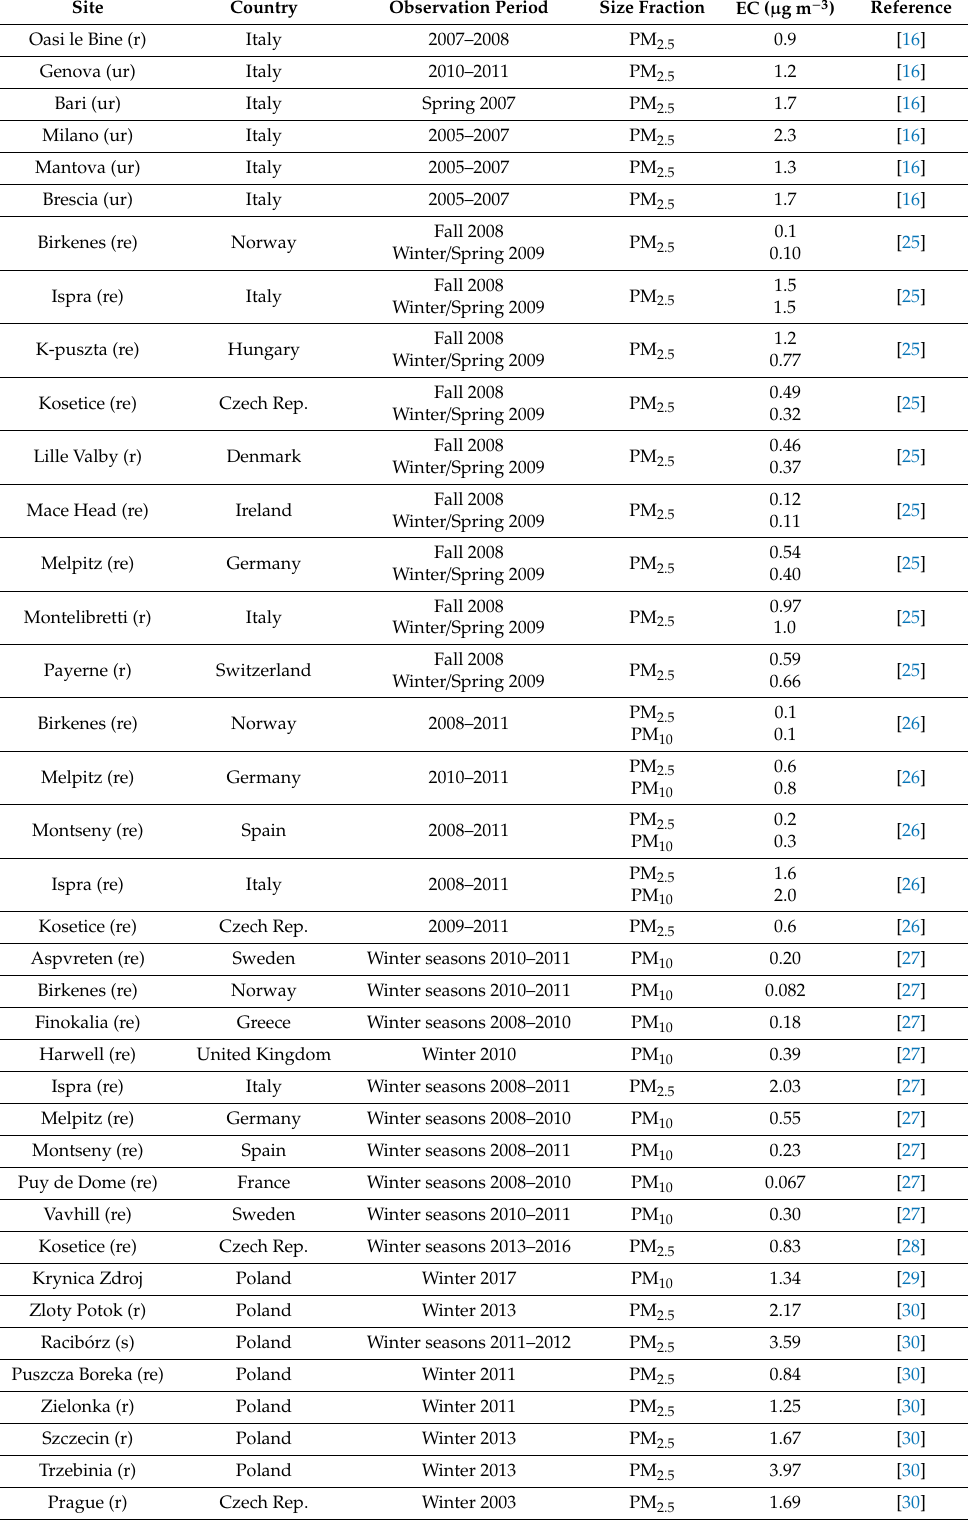
Table 1. Mean EC concentrations observed in PM 2.5 and PM 10 fraction in di ff erent European sites (re: regional background, r: rural, s: suburban, ur: